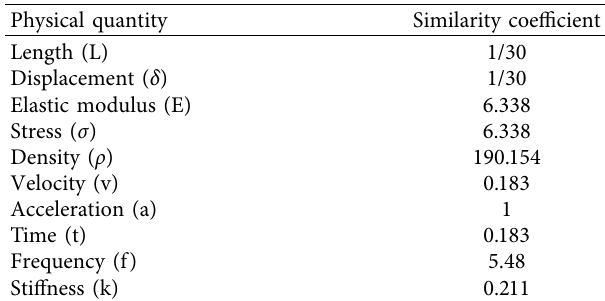
Figure 1: Wrap rope connection device structural diagram. Table 1: Similarity coefcients of every physical quantity (pro-